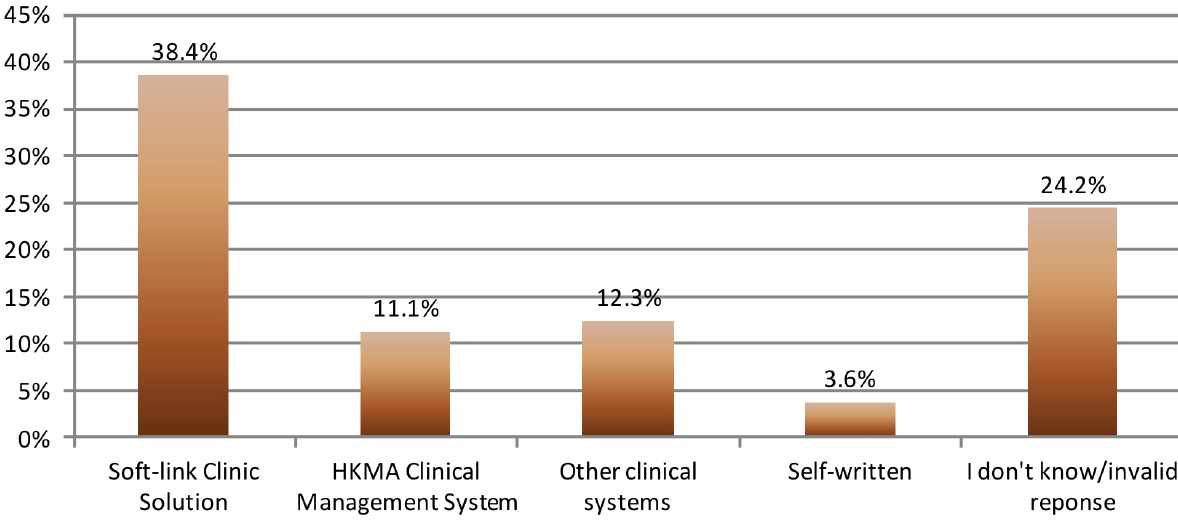
Figure 4. Names of computer system currently in use. Invalid response was defined as naming of computerized systems as Operation Systems (eg, Microsoft Vista) or computer hardware. HKMA: Hong Kong Medical Association.